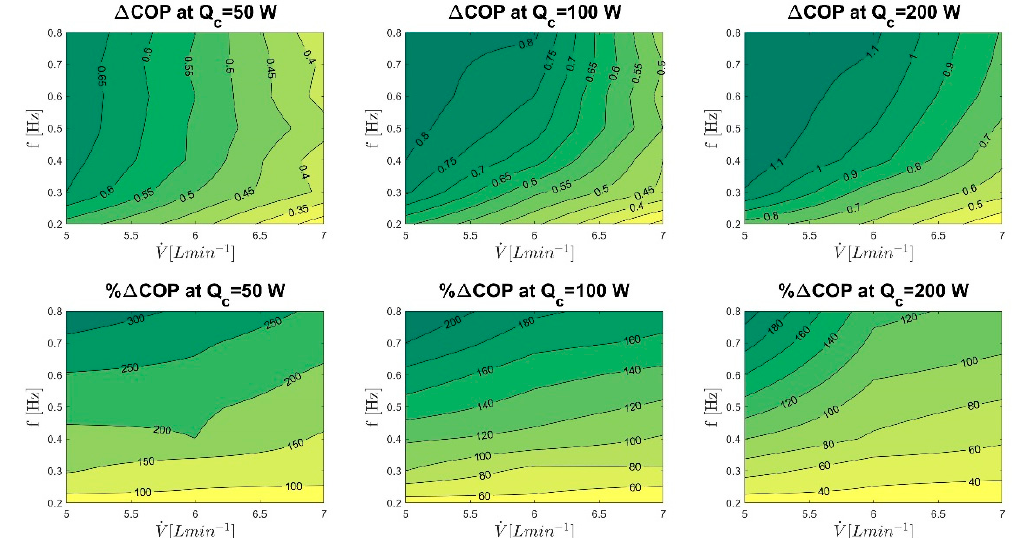
Figure 18. ‘8MAG’ COP changing by reducing both thermal losses in the rotary valve and ECL on the MCW for different operating conditions at T H = 22 °C. Temperature spans are in the range between 1 K and 8.5 K.